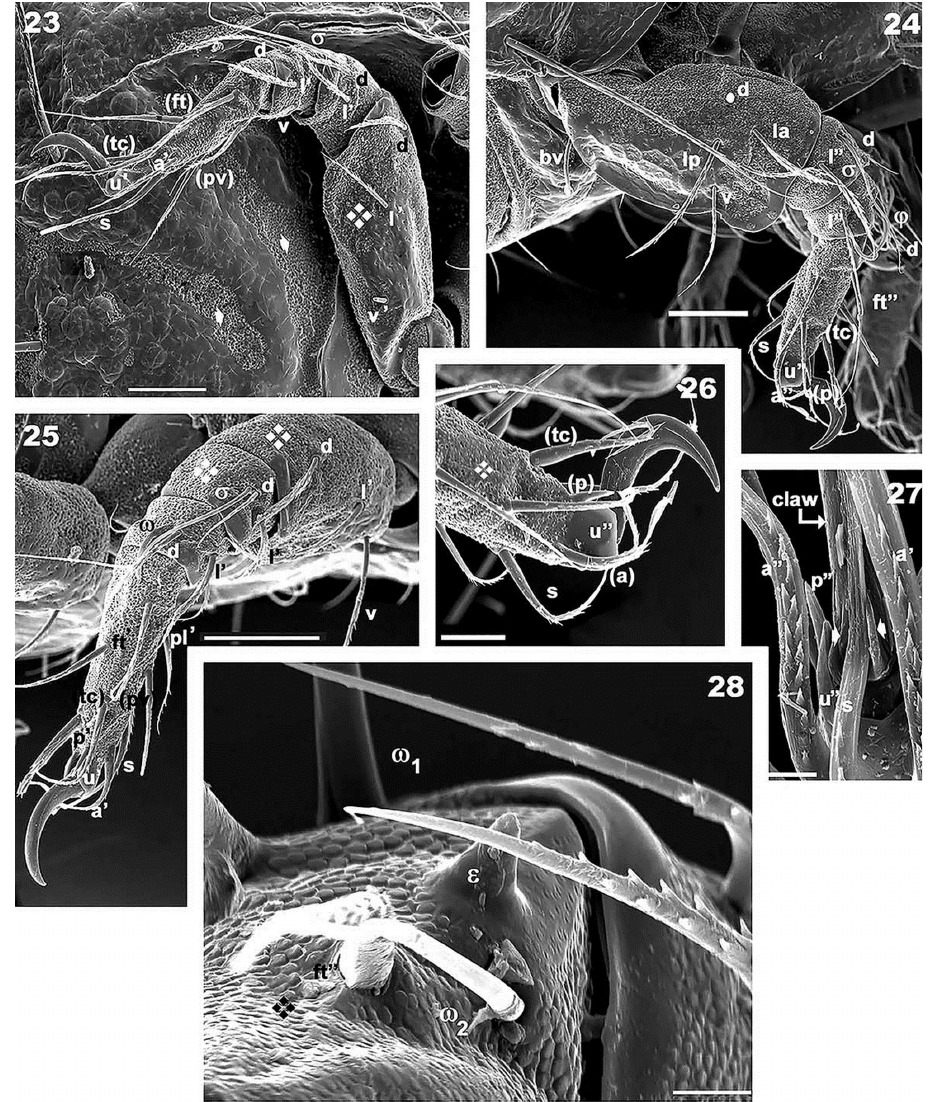
Figures 23–28. Meristacarus perikopesis sp. n. Adult female with cerotegumental layer. SEM micrographs. 23 leg IV paraxial view 24 leg II paraxial view 25 leg III 26 apical zone, leg II 27 ventral apical zone, leg II 28 tarsus I, famulus and solenidion zone. Scale bars: 50 μm ( 23–25 ); 20 μm ( 26 ); 5 μm ( 27, 28 ). taxa (e.g. Meristacarus, Mixacarus) ”. In 1997 Alberti et al. 1997: 58–63: indicated: “ In light microscopy they appear as distinct patches of higher transparency and show the fine striation perpendicular to the surface, that is typical of porose areas (Fig.29) ” and referred to SEM studies: “ This similarity is also evident with SEM (Fig.30 A) the porose areas are not visible from the exterior but very shallow depressions indicate sometimes their location